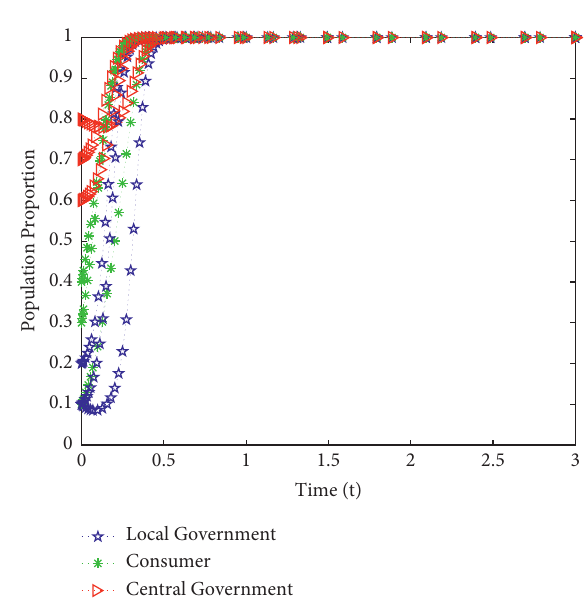
Figure 6: Evolution path of strategies chosen by three players with the stability point E 8 .